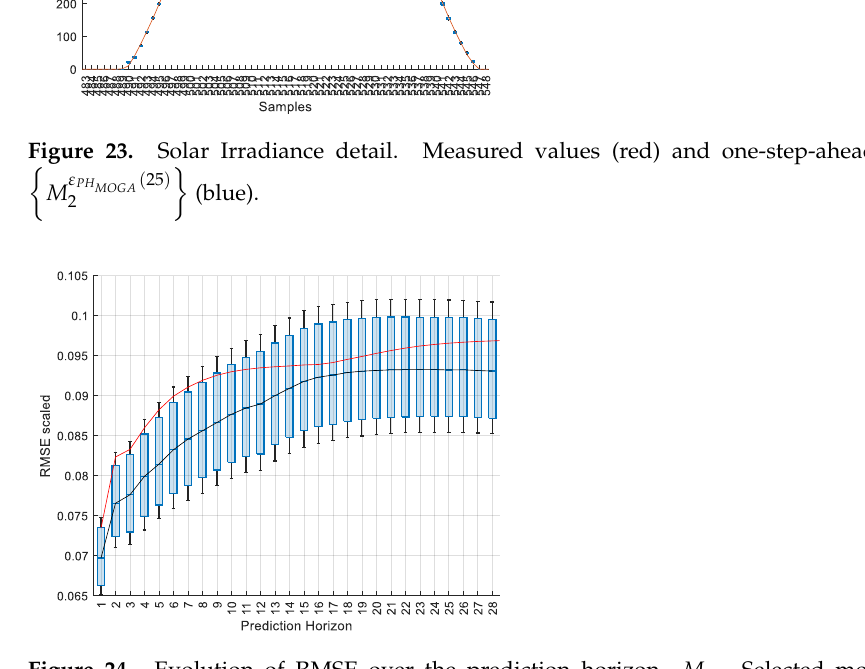
Table 8. Forecasting performances for M 3 .